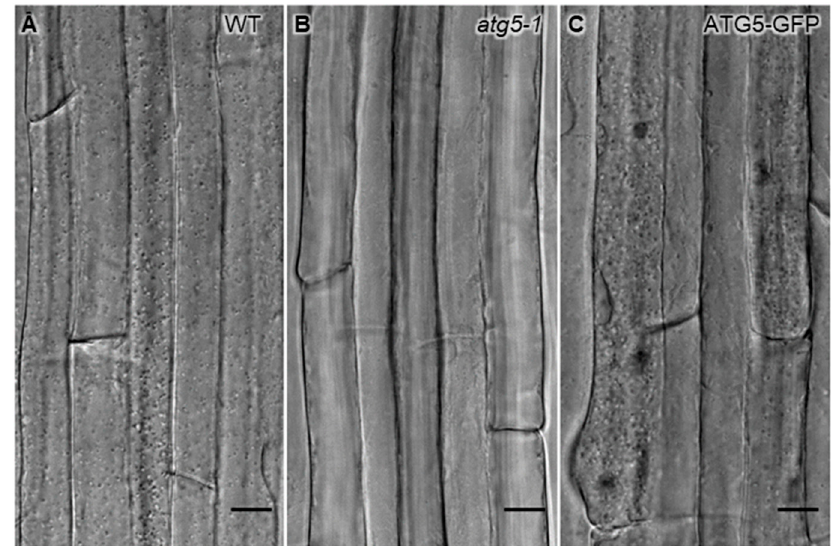
Figure 7. Expression of ATG5-GFP restores accumulation of autophagic bodies in atg5-1 plants. Differential Interference Contrast (DIC) micrographs of root epidermal cells incubated for 8 h with 1 µM concanamycin A in nutrient starvation conditions. ( A ) Autophagic body accumulation in the vacuole is clearly visible in wild-type (WT) seedlings, ( B ) but absent in the atg5-1 mutant, ( C ) and restored in atg5-1 seedlings expressing ATG5-GFP. Scale bar = 15 µm.